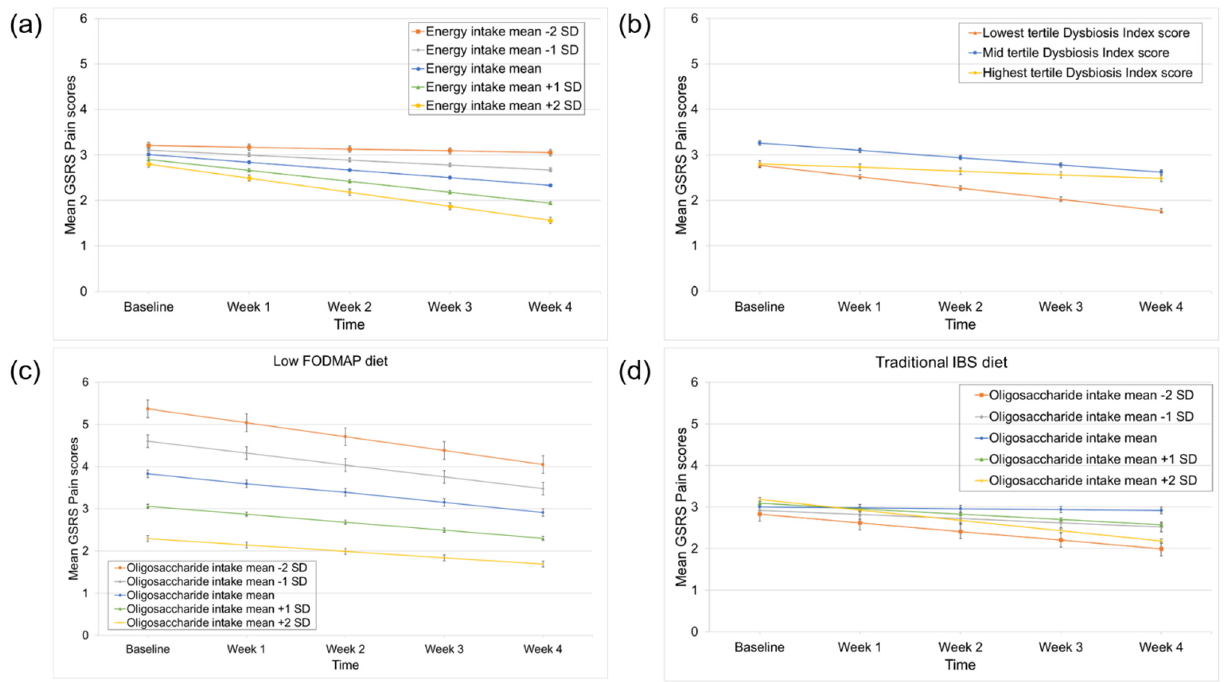
Figure 2. Predictors of pain improvement during the low FODMAP and traditional IBS diet. ( a ) Higher energy intake predicted better response to both diets. ( b ) Lower Dysbiosis Index scores predicted better response to both diets. ( c ) Oligosaccharide intake was a differential predictor with a non-significant association between higher baseline oligosaccharide intake and a worse response in low FODMAP treatment arm and ( d ) a significant association between higher baseline oligosaccharide intake and a better response in traditional IBS treatment arm. The GSRS-IBS subscales used in the linear mixed (i.e., random-effect) models were BoxCox transformed. For the transformation of the pain subscale, the following BoxCox formula was used: y ( λ ) = y original score range score of 1–7 to 0–6, using the formula: y ( 1 ) = y